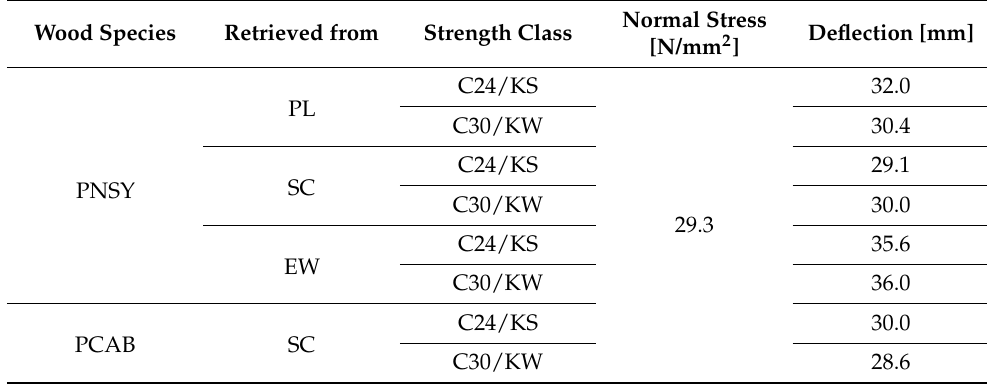
Table 7. Normal stresses and deflection (displacement) of C-version long frames made of glued material with a finger-jointed lamella length of 400 mm.